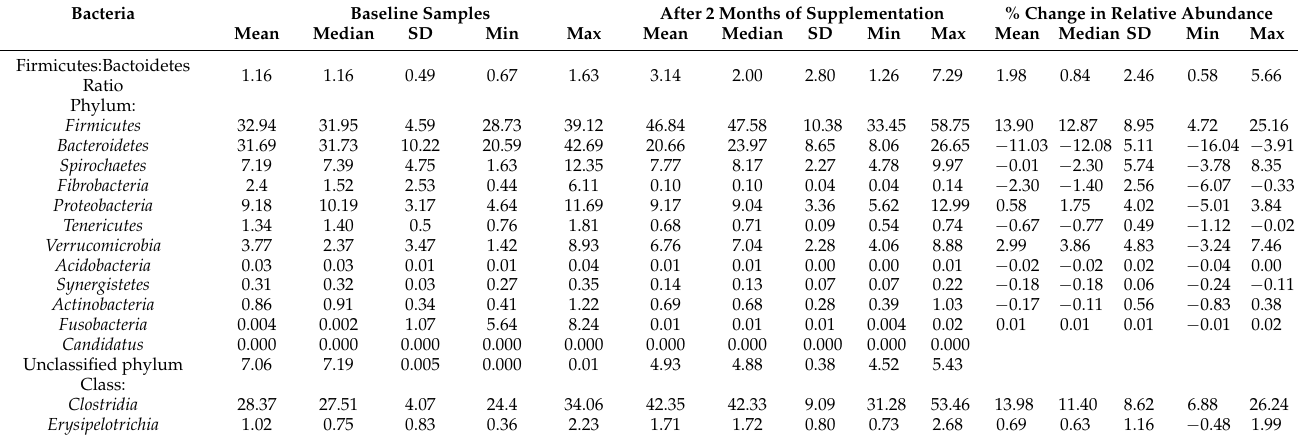
Table 1. Results of a pilot study of 4 horses supplemented for 2